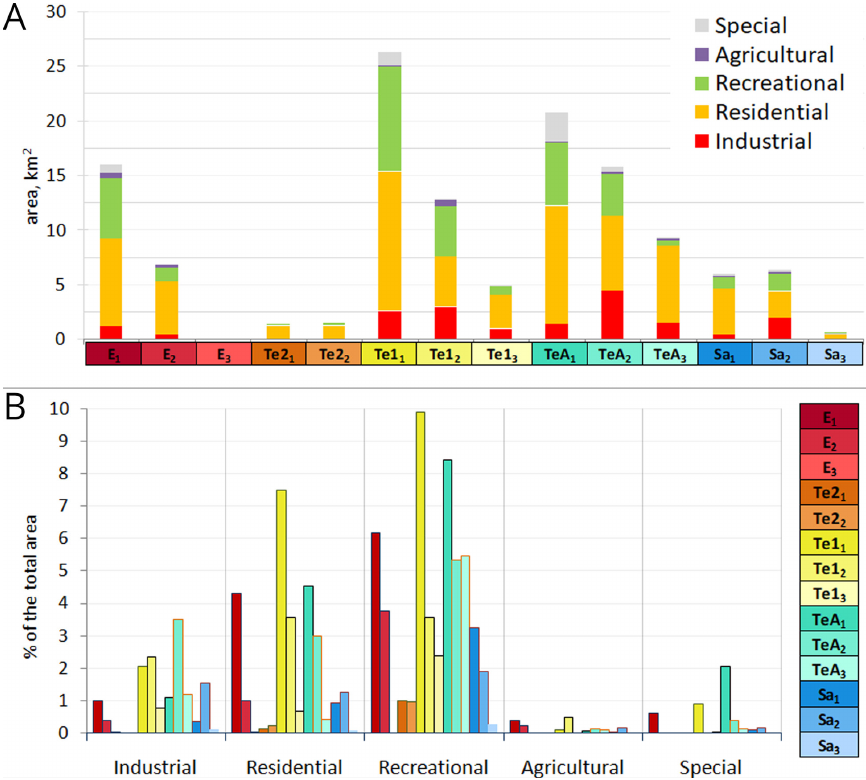
Fig. 13. The ratio of the area occupied by landscape zones. Decoding of indices in Figure